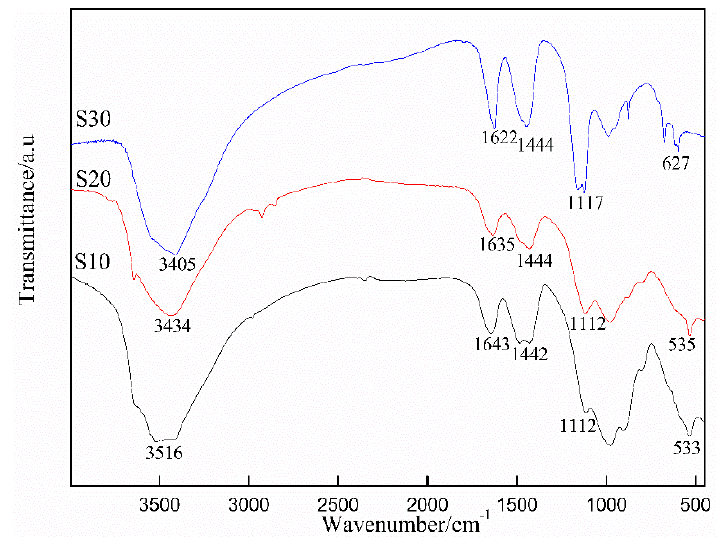
Figure 4. FTIR spectra of the samples (S10, S20,